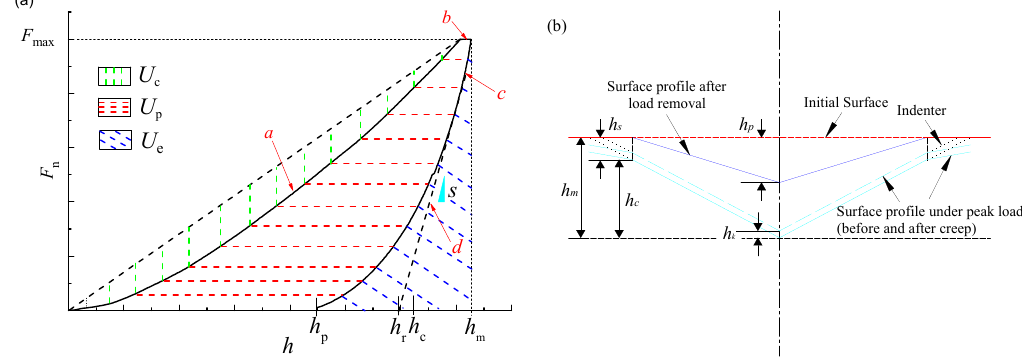
Figure 3. ( a ) Load-depth curve and ( b ) indent profile of the Berkovich indenter.